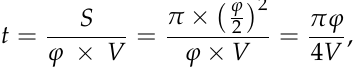
Table 2. Defined optical properties of the ray tracing analysis. Element Property Value Wavelength (nm) 355 Light Source Power (mW) 50–250 Material Acrylic Environmental Material Refractive Index 1.50